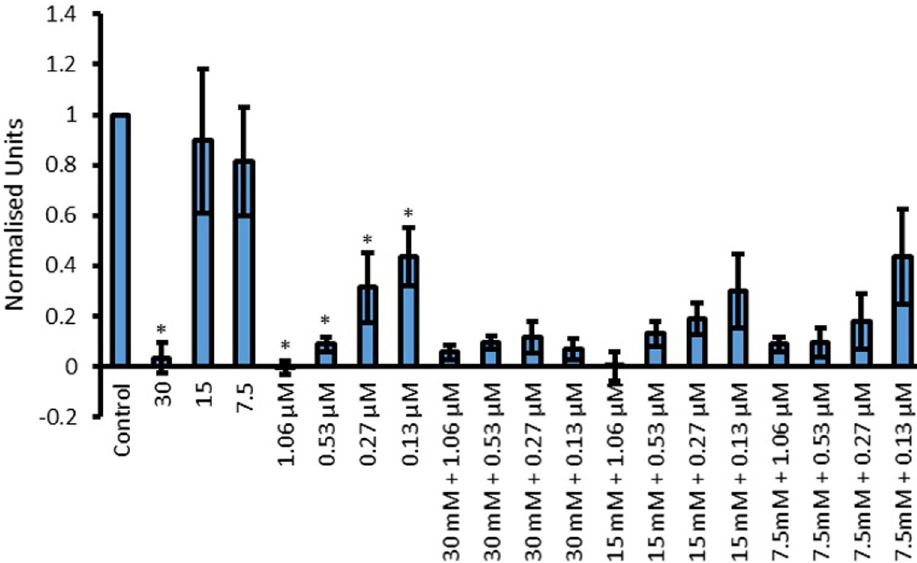
Fig 9. Effect of L-Asp, Cip and L-Asp with Cip combinations on the production of pyocyanin by P . aeruginosa . Y- axis shows concentration of pyocyanin in normalized units when treated with 30, 15 and 7.5 mM L-Asp, 1.06, 0.53, 0.27 and 0.13 μ M Cip and their combinations represented on the X-axis. Significant results are indicated by � , where � represent a significant reduction in pigment production by the amino acid or Cip compared to control (p < 0.05 was taken as significant); n = 3.